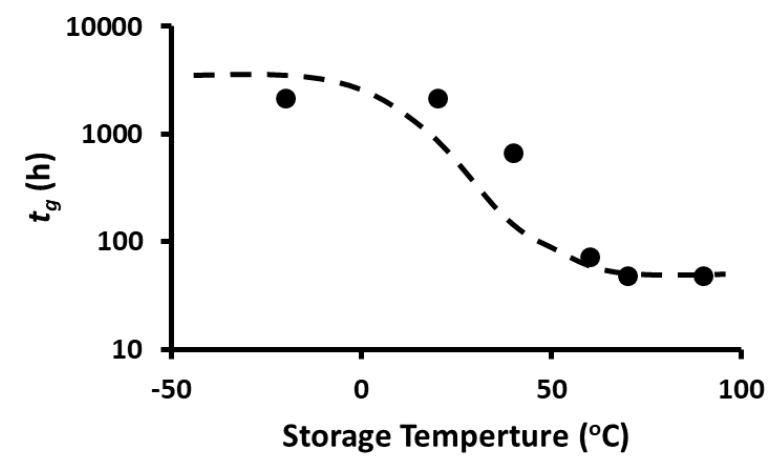
Figure 7. Peak polyphenol concentration as a function of storage temperature (line is a trend guide).